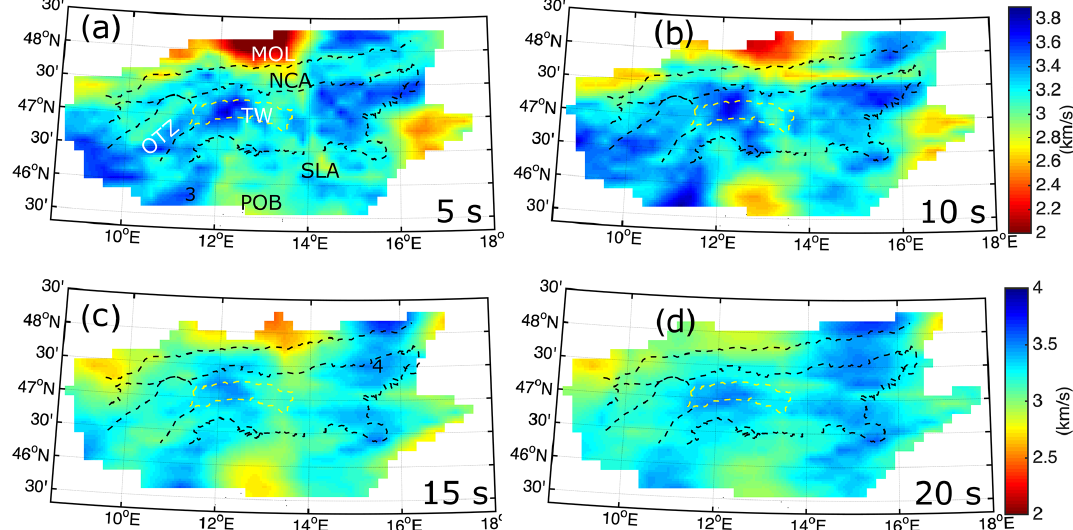
Figure 9. The obtained Love-wave group velocity maps at periods of 5, 10, 15, and 20s. See Fig. 9 caption for abbreviations. No. 4 at 15s shows a notable high-velocity anomaly in the easternmost part of the Northern Calcareous Alps (NCA). CZA: crystalline core zone of the Alps, OTZ: Ötztal block, TW: Tauern Window, MOL: Molasse Basin, POB: Po Basin, SLA: Southern Limestone Alps.